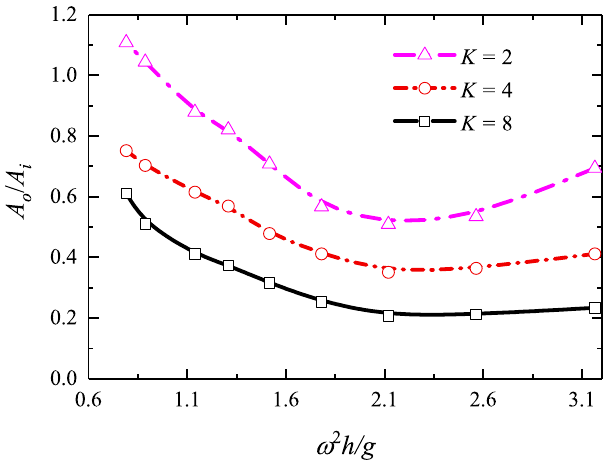
Figure 15. The relative amplitude of heave motion of the front OWC device as a function of the dimensionless frequency ω 2 h / g for K = 2, 4 and 8